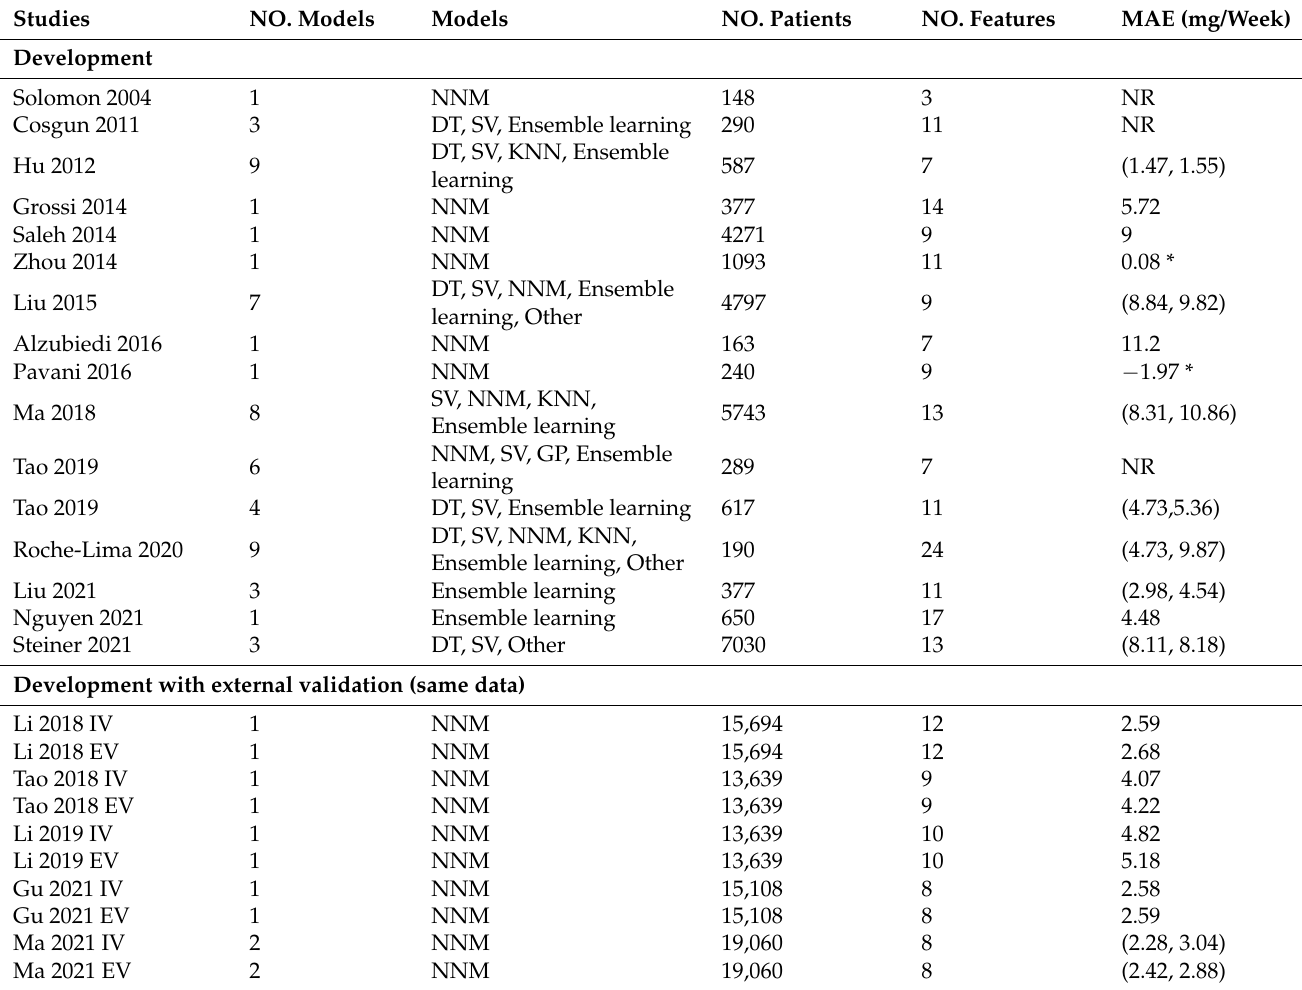
Table 2. Performance evaluation of the included nonlinear machine learning algorithms